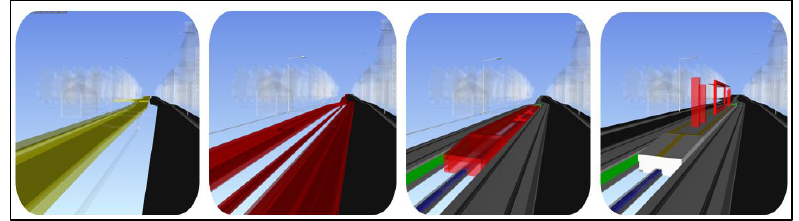
Figure 17. Example of subsequent construction